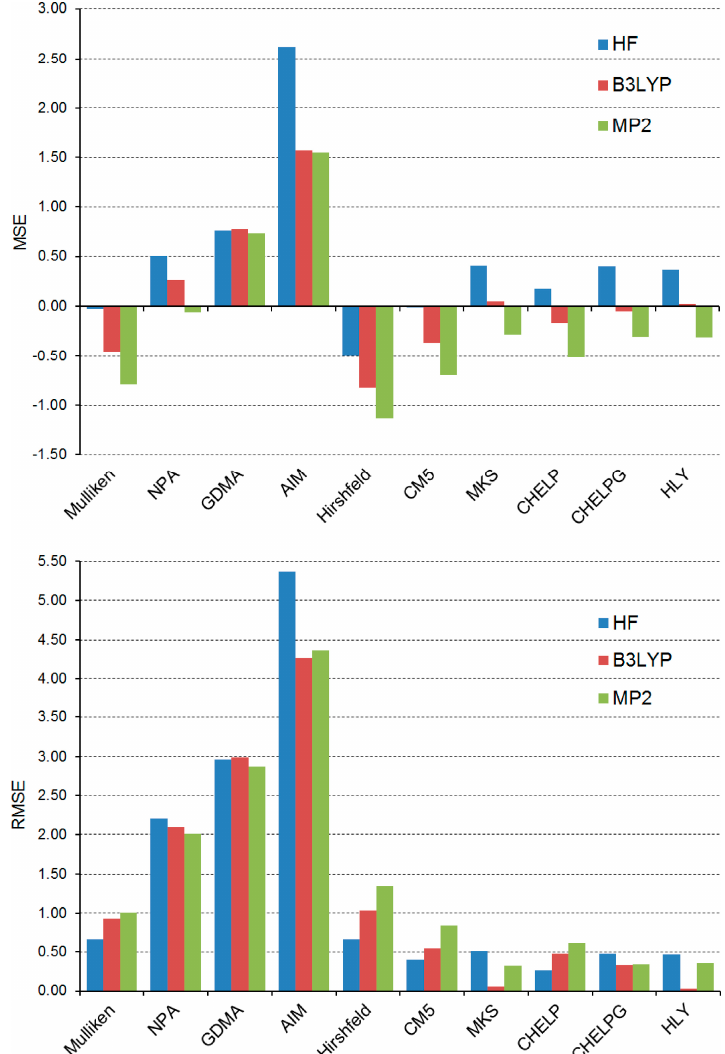
Figure 4. MSE and RMSE (in Debyes) in the μ values approximated by 10 models of partial atomic charge for 30 conformers of 1a – 5a and 1b – 5b . The errors are calculated relative to the reference results obtained from the full density at the B3LYP/def2-QZVPP level of theory.